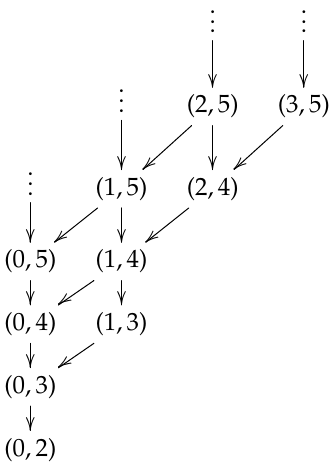
Figure 1. Answer sets for (18) without negative Figure 1. answer sets for (18) without negative values.